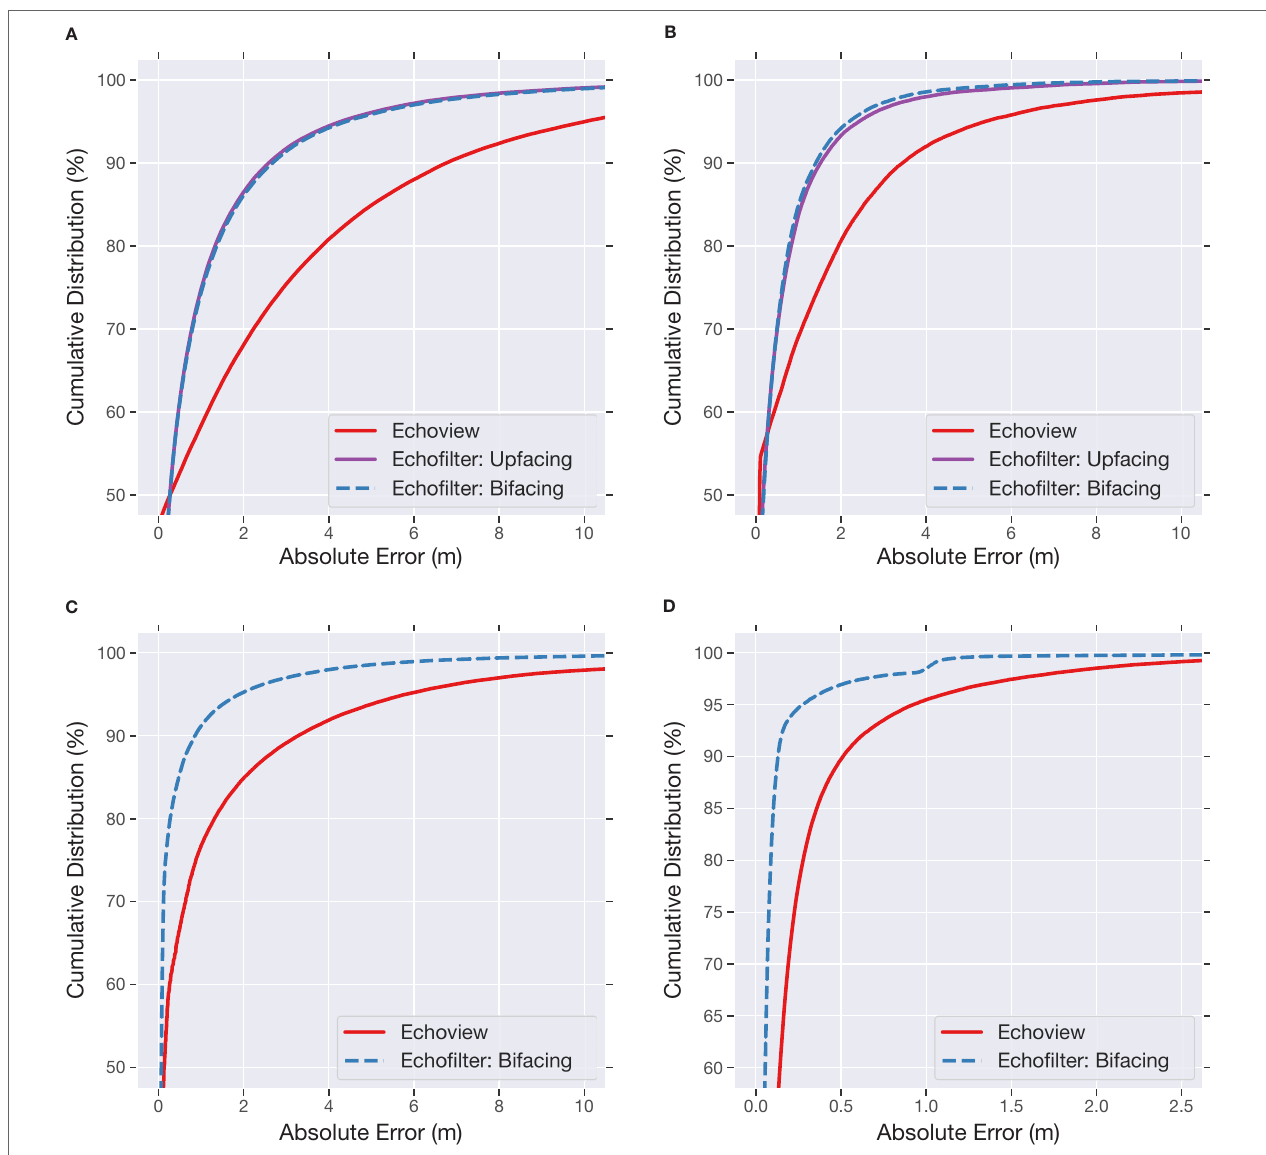
FIGURE 3 | Cumulative distribution for the absolute error of entrained-air (A–C) and seafloor (D) lines generated by the models (Echoview: red; Upfacing@400ep: magenta; Bifacing@700ep: blue). This indicates (on the y-axis) the fraction of pings where the output line was within a given threshold distance (x-axis) of the target line. (A) Error in entrained-air line on MP:sta ↑ . (B) Error in entrained-air line on GP:sta ↑ . (C) Error in entrained-air line on MP:mob ↓ . (D) Error in seafloor line on MP:mob ↓